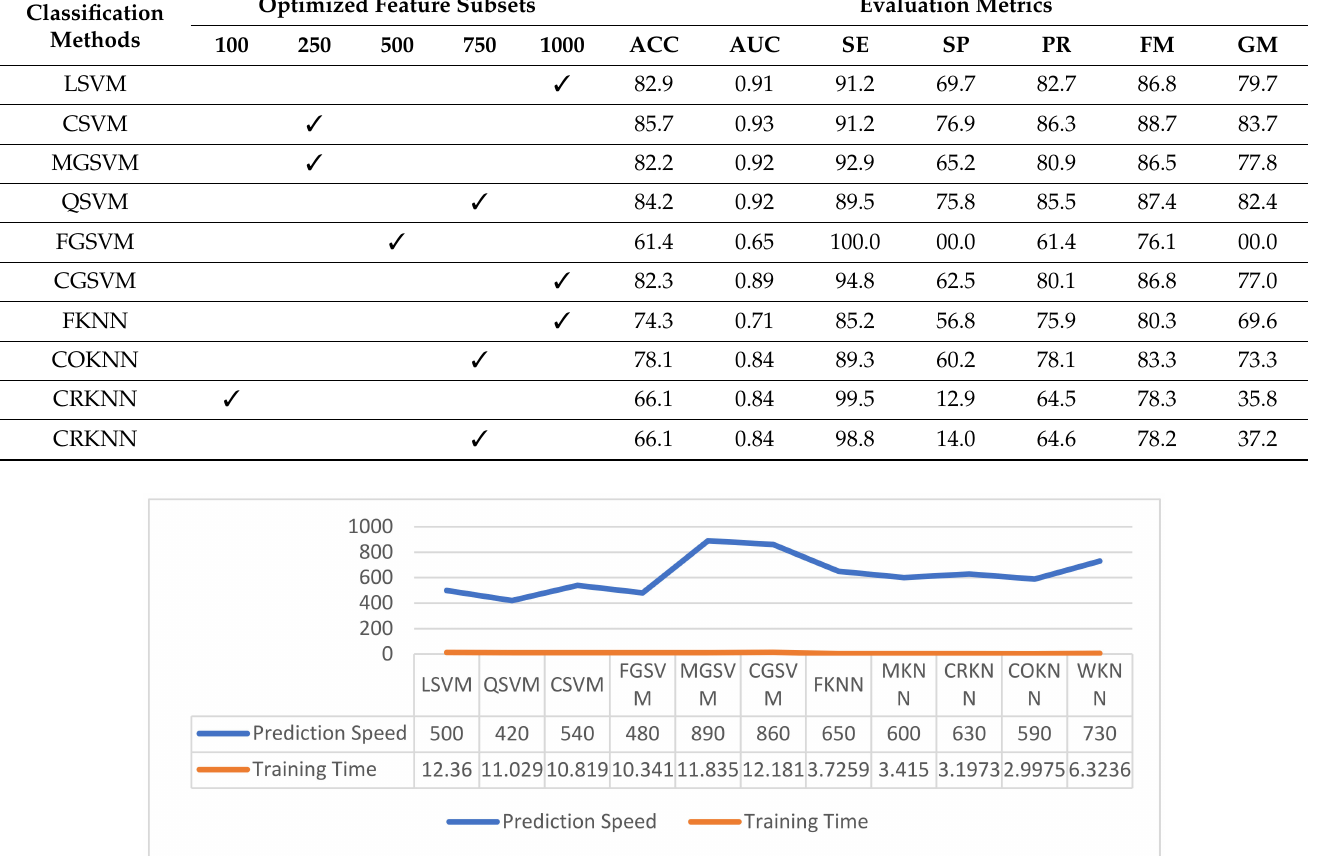
Figure 14. Proposed model training time (s) and prediction speed (obs/s) on front views of PKU-Reid dataset utilizing 1000-feature subset.